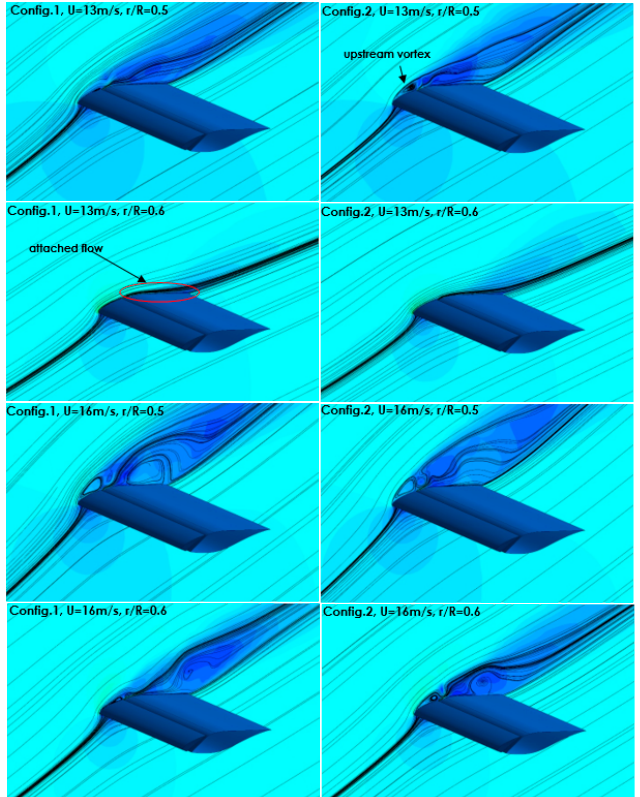
Figure 11. Streamlines and velocity distributions for configurations 1 and 2 compared to baseline at r/R = 0.5 and r/R = 0.6 for windspeeds U ∞ = 13 m s − 1 and 16 m s − 1 .